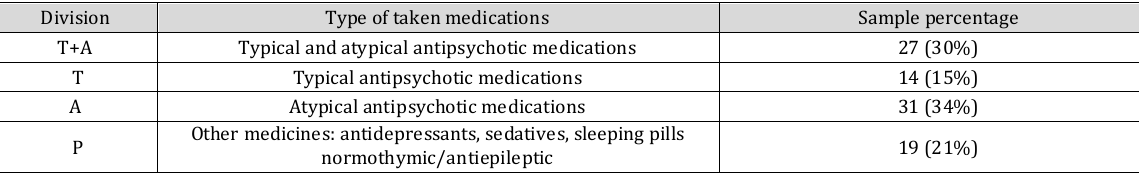
Table 1. Groups divided by the types of taken medications.